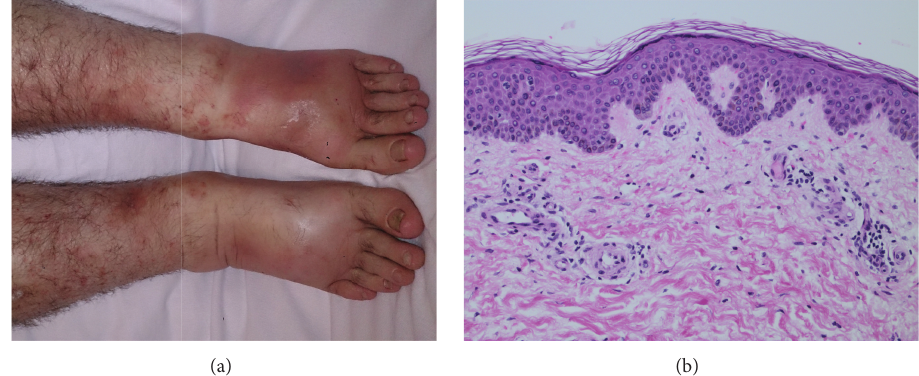
Figure1:(a)Photographofthepatient’sresolvingpurpurainvolvinghislegsoneweekintoantibiotictherapy.(b)Correspondinghematoxylin and eosin-stained histopathology at 20x magnification of a punch biopsy of one of the lesions on his leg, showing mild perivascular inflammation with focally extravasated erythrocytes consistent with a resolving purpuric process. No leukocytoclastic vasculitis was